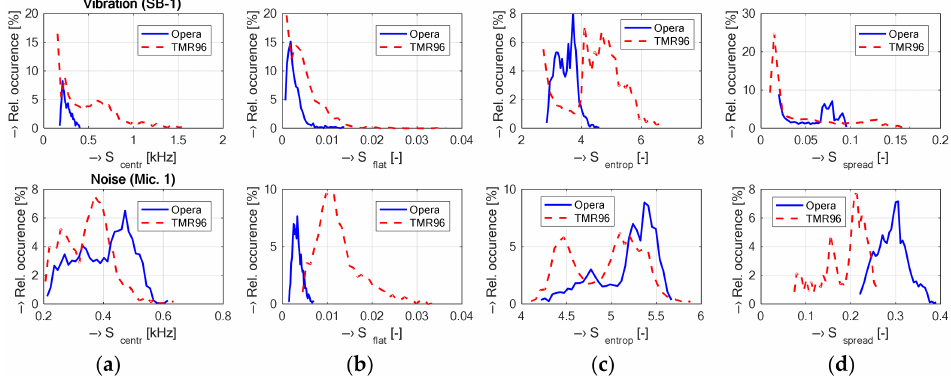
Figure 8. Histograms of supplementary spectral properties; ( a ) S centr ; ( b ) S flat ; ( c ) S entrop ; ( d ) S spread , determined from picked-up vibration signals inside the Opera and TMR96 MRI